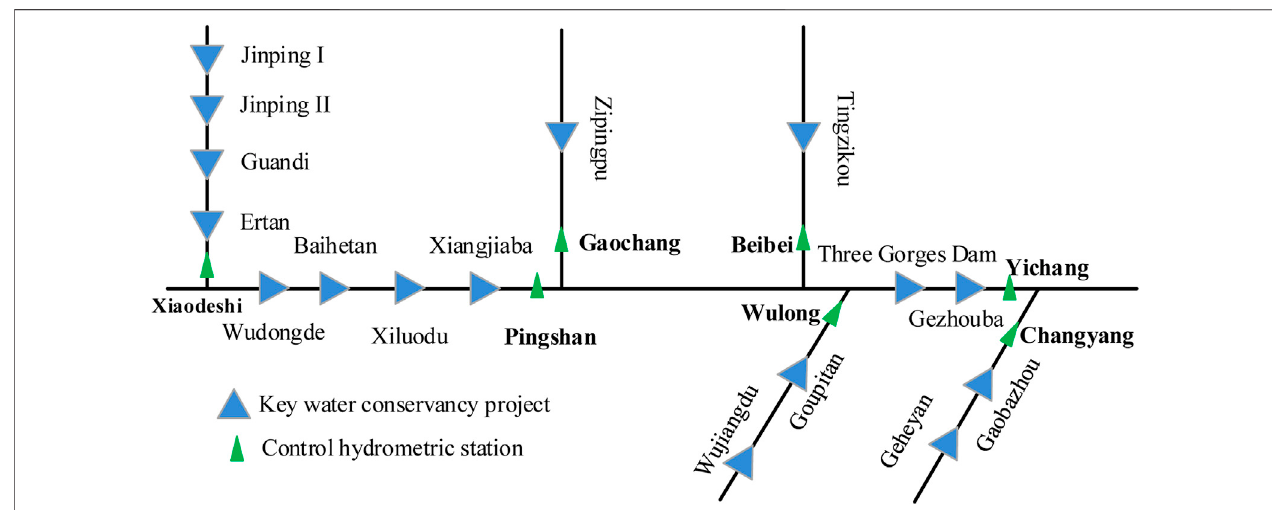
FIGURE 4 | The general graph of the key water conservancy project location in the upper Yangtze River.